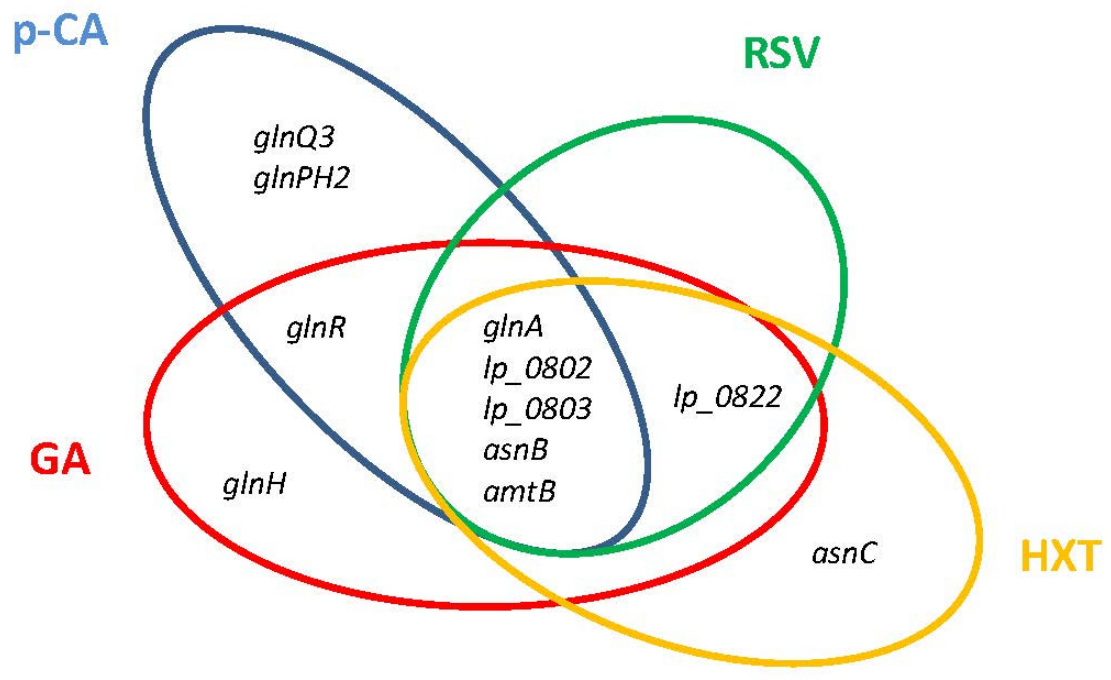
Figure 3. Venn diagram assembled from Lactiplantibacillus plantarum WCFS1 GlnR regulon genes involved in nitrogen metabolism that are differentially downregulated in response to individual plant phenolic compounds. p -CA, p -coumaric acid; RSV, resveratrol; HXT, hydroxytyrosol; GA, gallic acid.